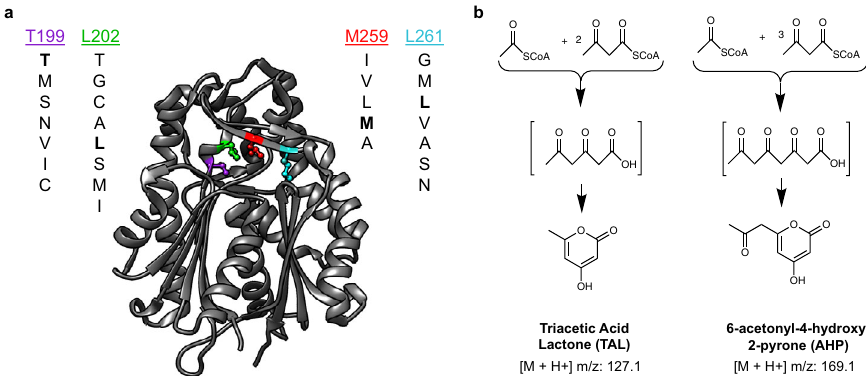
Fig. 2 Overview of the type-3 PKS variant library. a Crystal structure of Gerbera hybrida G2PS1 (PDB ID: 1EE0) showing the location of the four residues selected for mutagenesis and identity of the residue mutants. All residues except T199 directly form the active site cavity. b The smallest condensation/ cyclization products expected from type III polyketide synthase activity: triacetic acid lactone (TAL, the native product of G2PS1) from one acetyl-CoA and two malonyl-CoA and 6-acetonyl-4-hydroxy-2-pyrone (AHP) from one acetyl-CoA and three malonyl-CoA. Higher-order polyketides, not shown, are possible from additional condensations of malonyl-CoA.